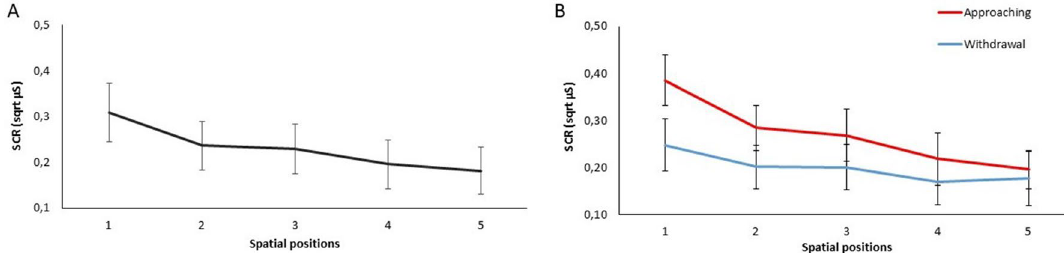
Figure 2. A physiological measure of interpersonal distance. The graph illustrates modulations of skin conductance responses (SCRs; expressed in sqrt µS). In the left panel, SCR is expressed as a function of Spatial positions (1–5) ( A ). In the right panel, SCR is expressed as a function of Movement (Approaching and Withdrawal) and Spatial positions (1–5) ( B ). Error bars indicate 95% confidence